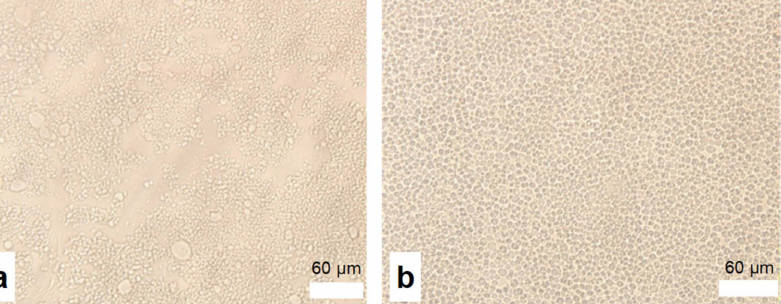
Figure 1. Micrographs of the copolymer particles in a “water-in-water” emulsion. ( a ) P (AM- co -DMC) (CW101); ( b ) P (AM- co -DMC- co -DM8)